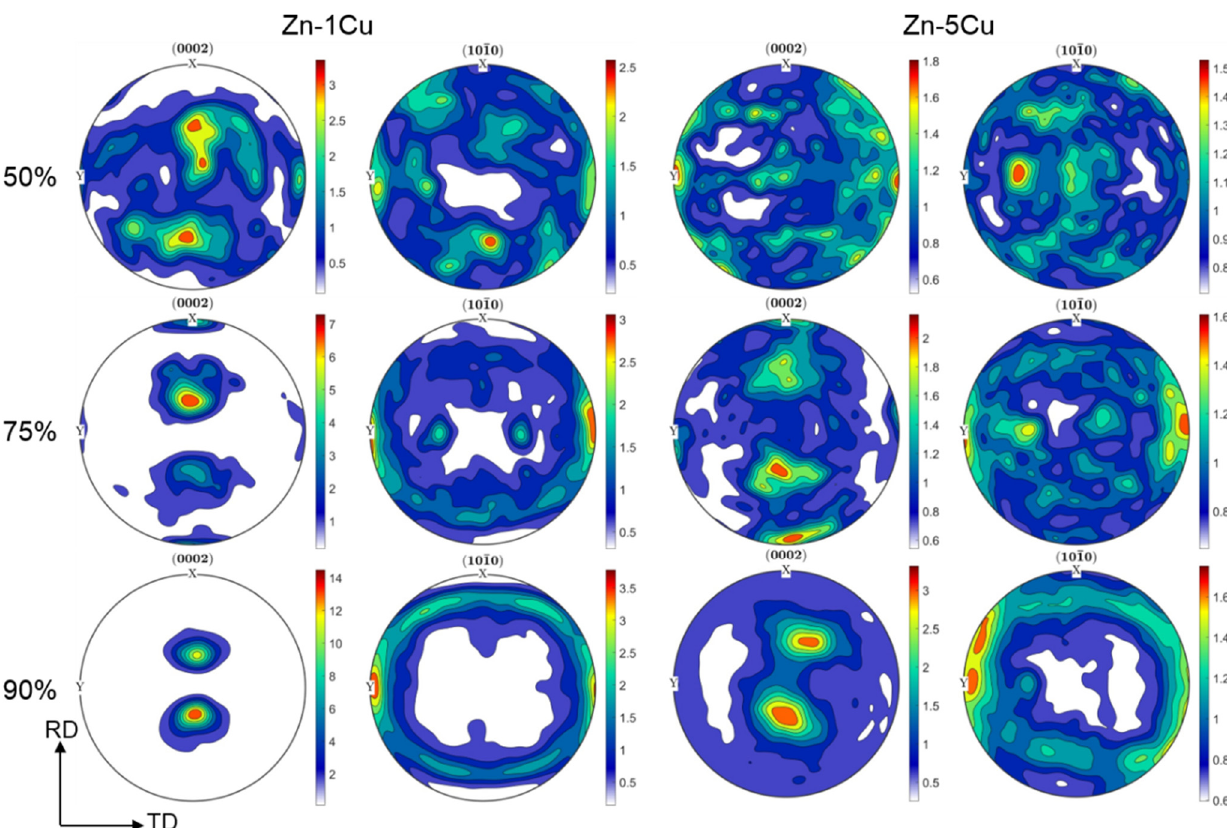
Figure 6. (0002) and (1010) pole figures of the Zn-1Cu (left side) and Zn-5Cu (right side) alloys after cold rolling with reduction rate 50% (top row), 75% (middle row) and 90% (bottom row).